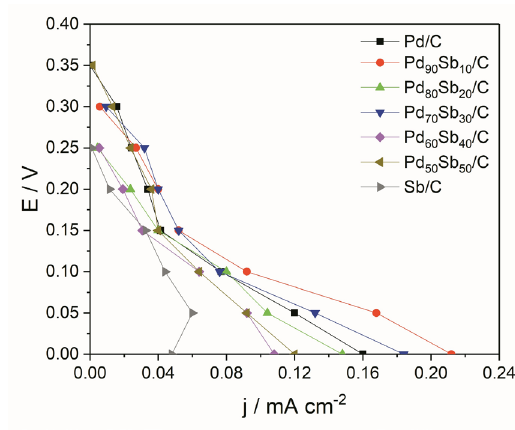
Figure 6. Polarization curves of a 5 cm 2 SER-FC at room temperature using PdSb/C catalysts anodes saturated 2